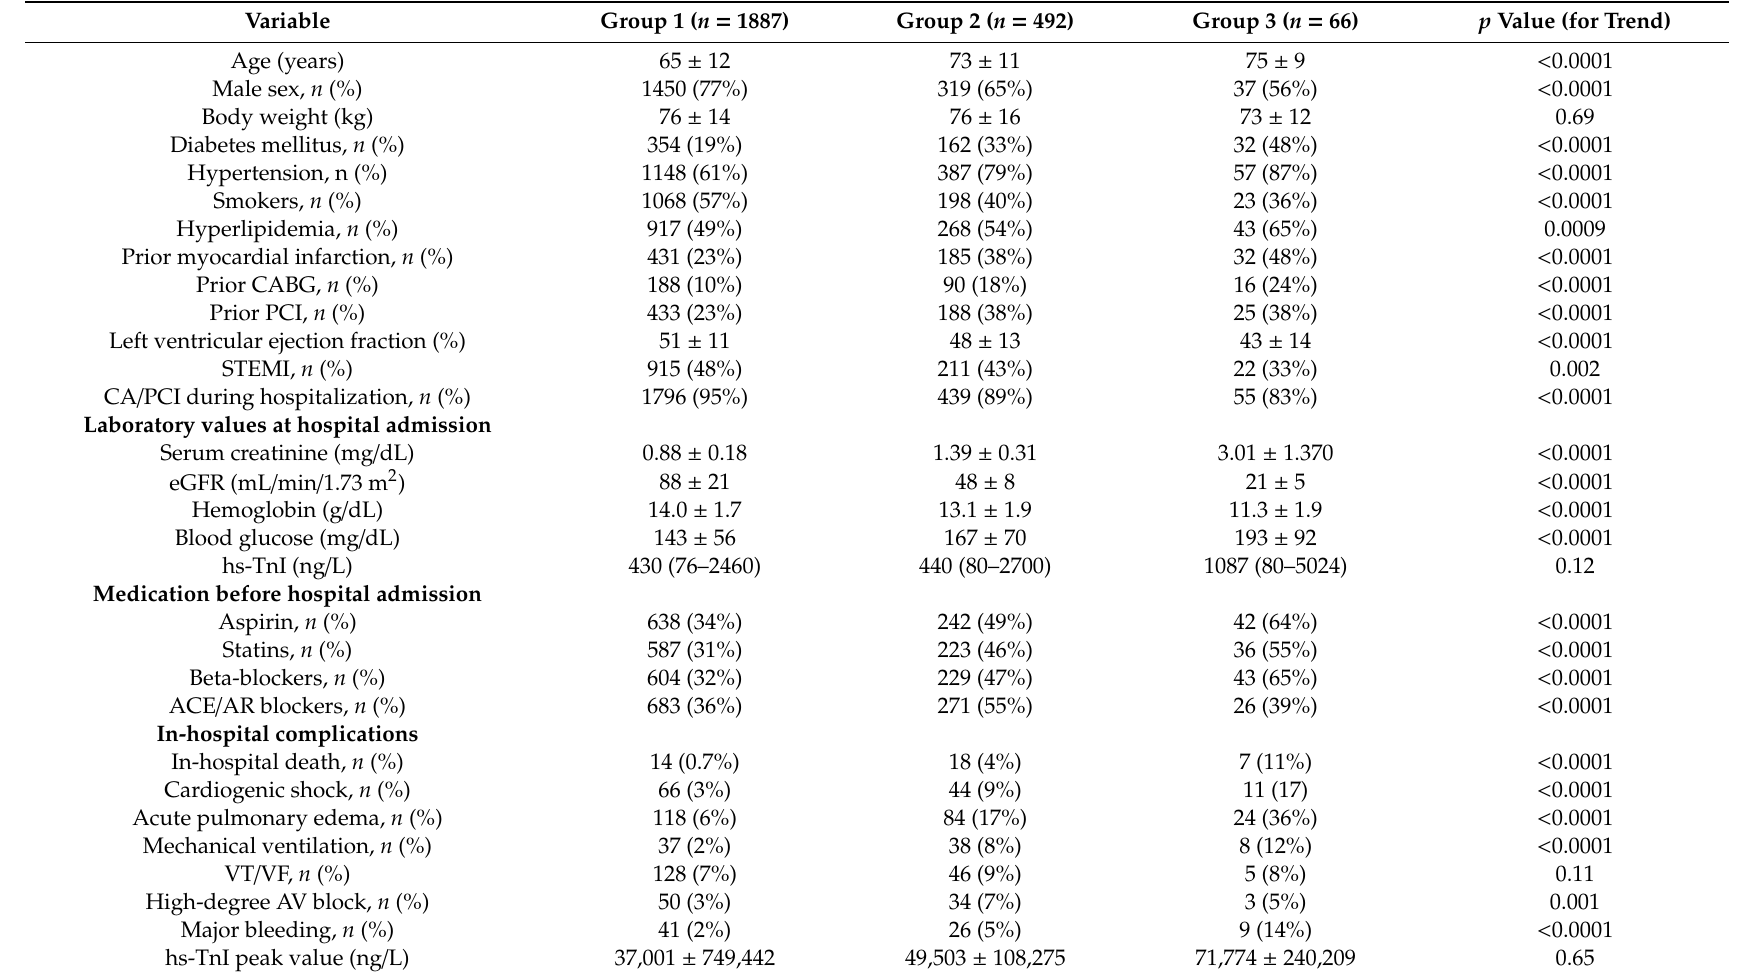
Table 2. Baseline characteristics and in-hospital complications in the three study